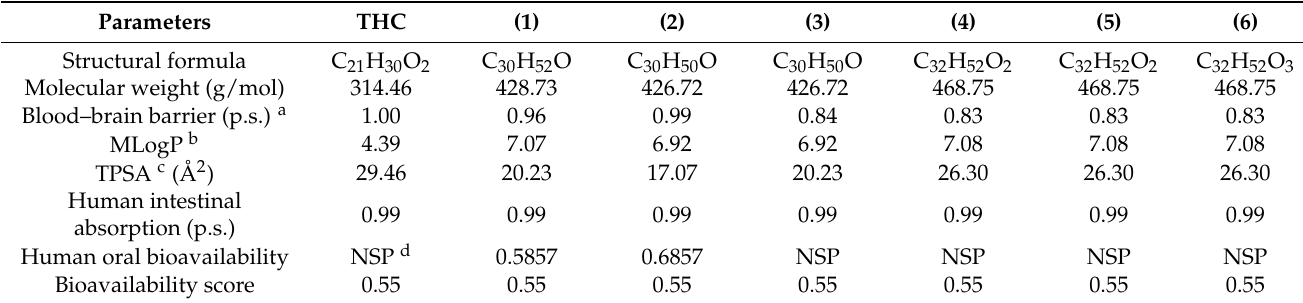
Table 1. Drug-likeness parameters prediction for tetrahydrocannabinol (THC), epifriedelanol ( 1 ), friedelin ( 2 ), α -amyrin ( 3 ) and α -amyrin acetate ( 4 ), β -amyrin acetate ( 5 ), and bauerenyl acetate ( 6 ).